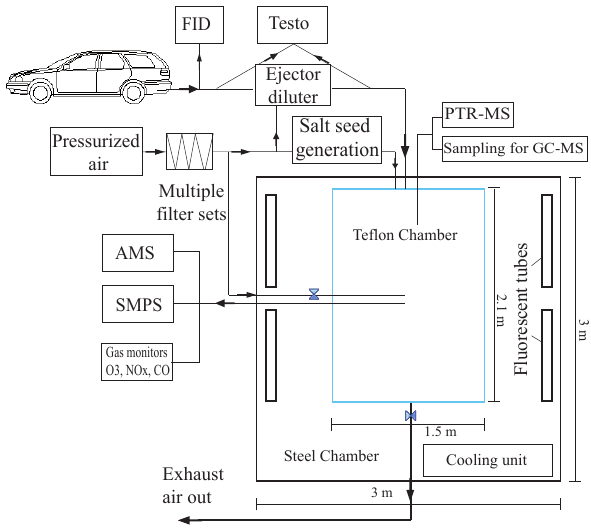
Fig. 1. Schematic representation of the smog chamber and dilution system, seen from